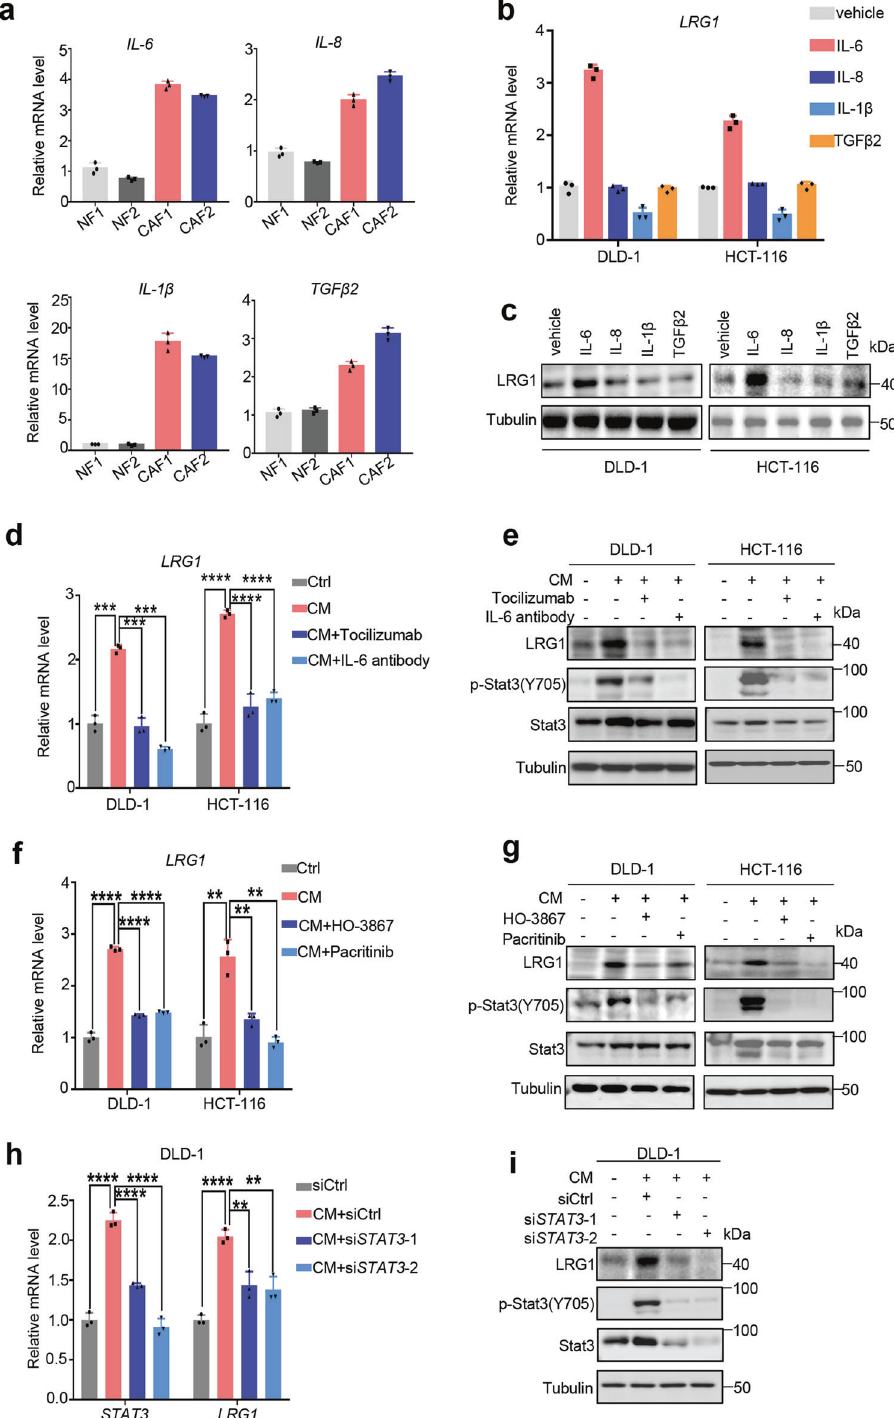
Fig. 4 CAFs-secreted IL6 up-regulates LRG1 through activating JAK2/STAT3 signaling. a QRT-PCR analysis of IL-6/IL-8/IL-1 β /TGF β 2 mRNA level in CAFs compared to NFs. b & c . QRT-PCR and western blot analysis of LRG1 expression in DLD-1 and HCT-116 treated with vehicle or recombinant IL-6/IL-8/IL-1 β /TGF β 2. d , e . DLD1 and HCT-116 were cultured with control medium, CM from CAF1 or treated with neutralizing antibody either targeting IL-6R or IL-6 when cultured with CM from CAFs as indicated. Expression of LRG1 was measured by qRT-PCR and western blot. Blots were probed against LRG1, phosphorylated STAT3(Y705), total STAT3 and β -tubulin. f , g DLD1 and HCT-116 were cultured with control medium, CM from CAFs or treated with HO-3867 (STAT3 inhibitor) or pacritinib (JAK2 inhibitor), when cultured with CM from CAFs as indicated. Expression of LRG1 was subsequently analyzed by qRT-PCR and western blot. Blots were probed against LRG1, phosphorylated STAT3(Y705), total STAT3 and β -tubulin. h , i DLD1 was transfected with control siRNA or two independent siRNA targeting STAT3, followed by culturing with control medium or CM from CAFs. Expression of LRG1 and STAT3 was measured by qRT-PCR and western blot. Blots were probed against LRG1, phosphorylated STAT3(Y705), total STAT3 and β -tubulin. Error bars represent SD; n = 3. ** P < 0.01, *** P < 0.001, **** P <